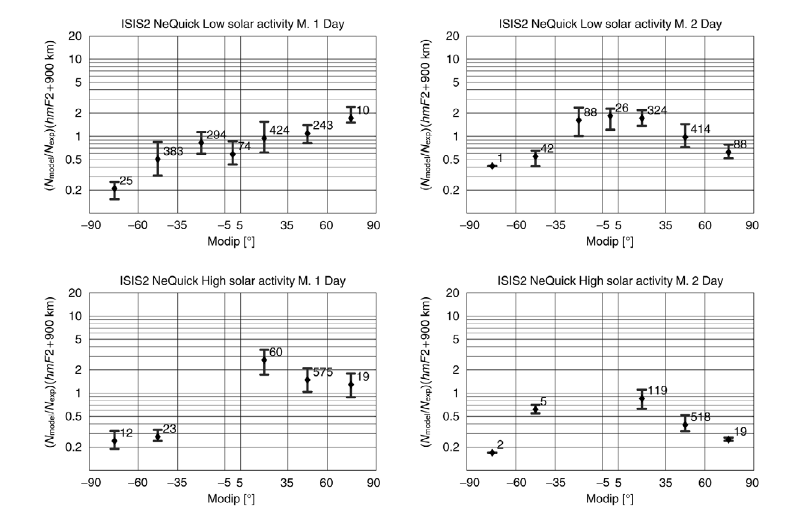
Fig. 5. Comparison of electron density, NeQuick model, at 900 km above hmF 2 for months groups 1 and 2. Numbers indicate the amount of